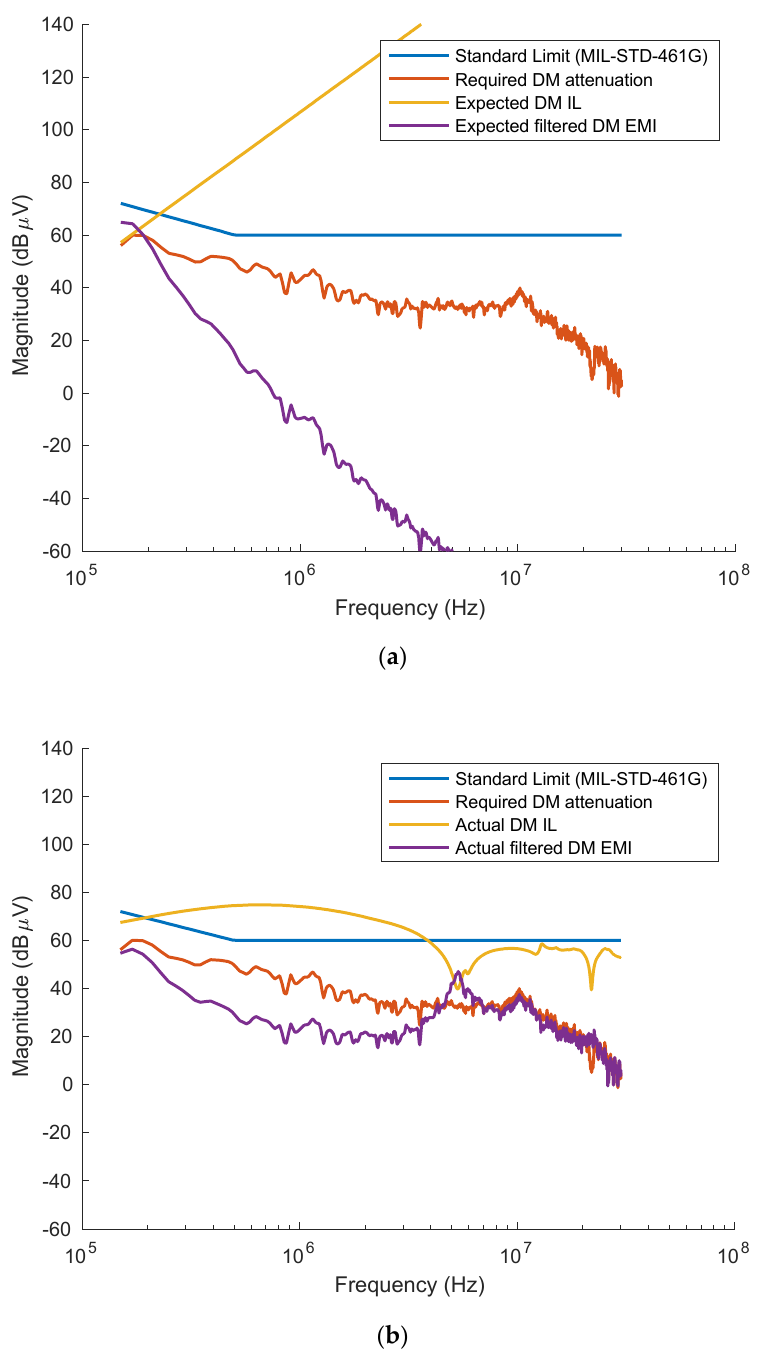
Figure 12. DM performance of the filter designed using [25]: expected ( a ) and actual ( b ).